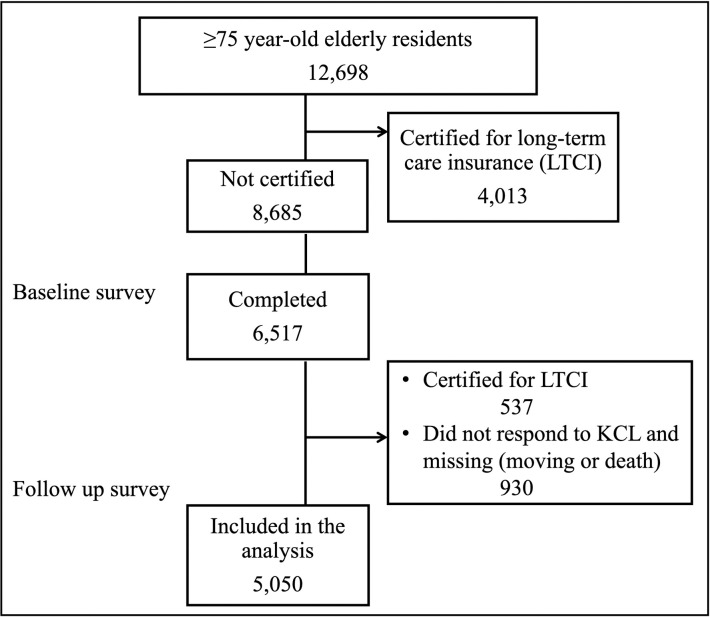
Flow chart of participant selection.